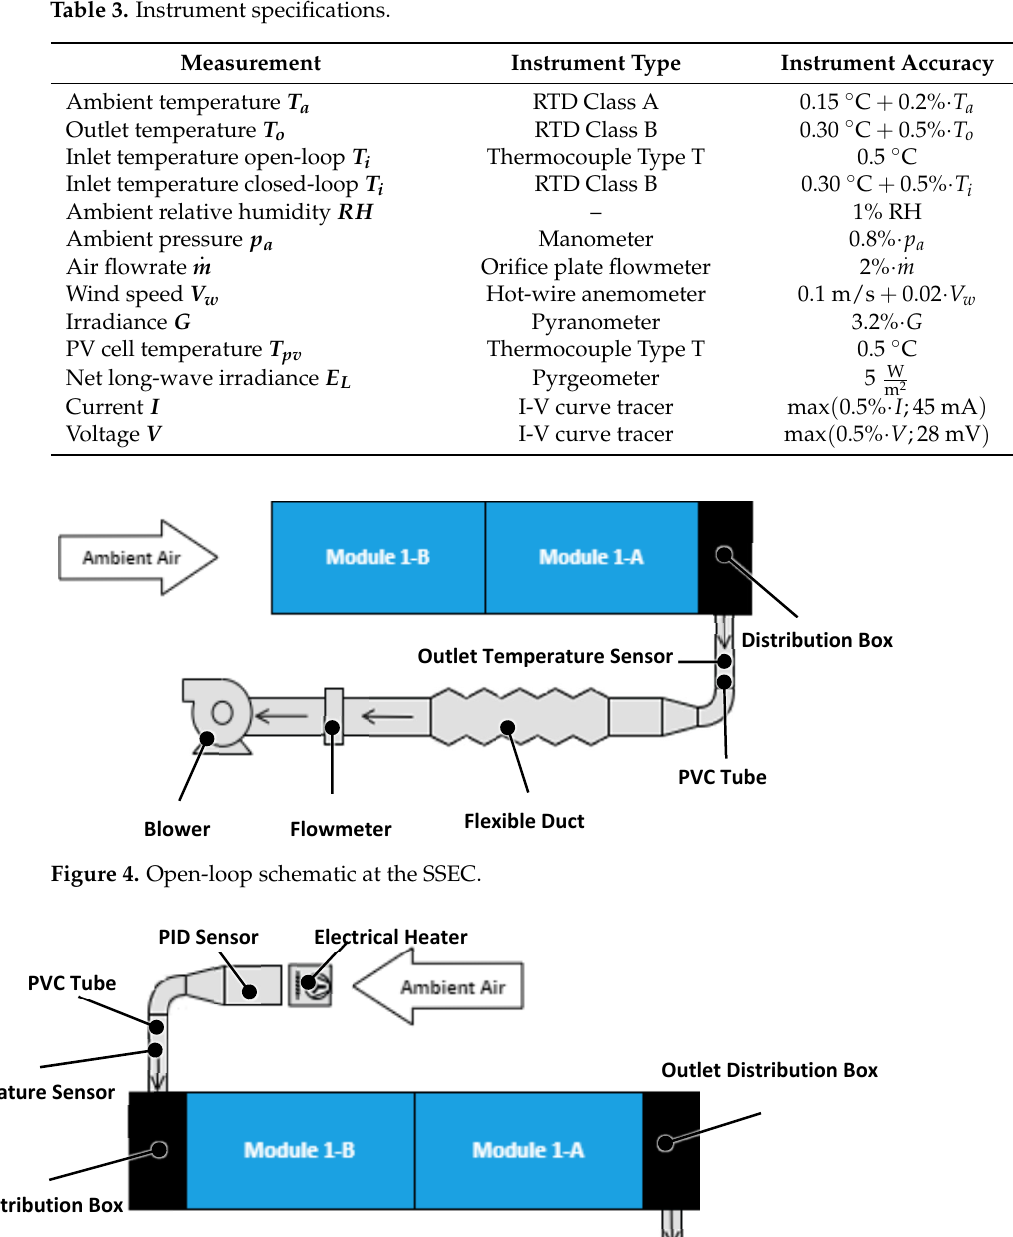
Table 3. Instrument specifications.